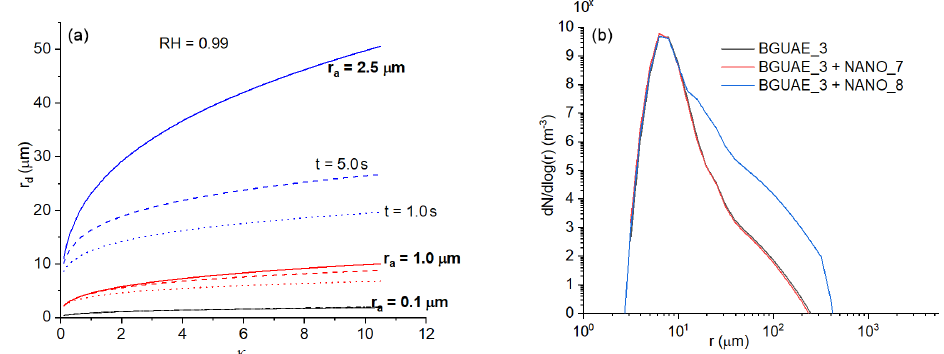
Figure 7. The impact of the size ( r a ) and hygroscopicity ( κ) of the seeding material. Panel (a) shows the equilibrium drop sizes formed on the aerosol particles with a different radius and different hygroscopicity (solid lines). Dotted and dashed lines denote the drop radius calculated by Eq. (1) after 1 and 5s, respectively. Panel (b) shows how the small particles with large hygroscopicity (NANO_7) and large particles with smaller hygroscopicity (NANO_8) impact the evolution of the DSD. The black line denotes the DSD for the control case 1km above the cloud